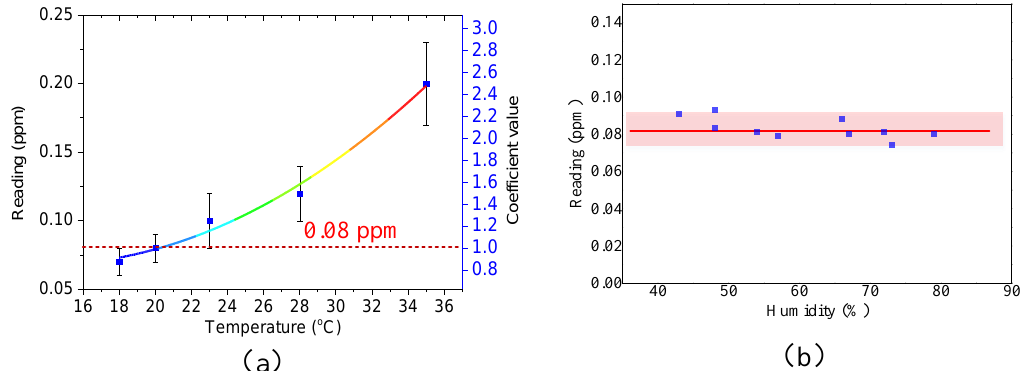
Figure 7. ( a ) The relationship between the reading of the calibrated system and the temperature in the presence of 0.08 ppm formaldehyde. The red dot line refers to the 0.08 ppm under 20 °C. The blue y-axes on the right show the corresponding coefficient values. ( b ) The blue dots show the reading at a different relative humidity from 40% to 80%. The light red box shows the range of the reading.